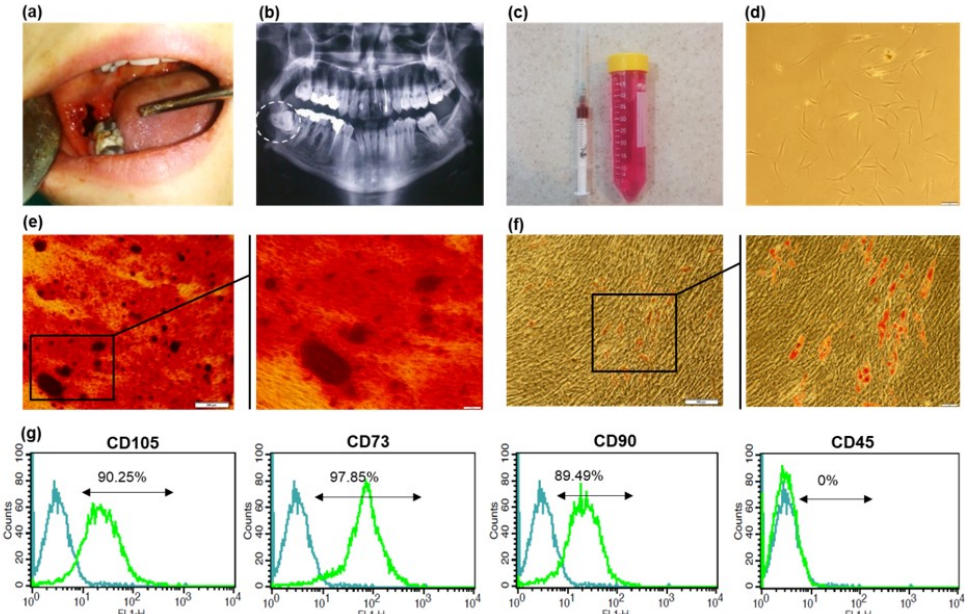
Figure 1. Isolation and characterization of a BMSCs. ( a ) Surgical extraction of impacted wisdom tooth ( b ) Panoramic radiography ( c ) Aspirated bone marrow in a heparinized syringe and alveolar bone particles in cell culture solution ( d ) Primary culture (P0) of aBMSCs with typical fibroblastic morphology (scale bar 100 µm) ( e ) Alizarin Red staining and ( f ) Oil Red staining of aBMSCs, following three weeks of osteogenic and adipogenic differentiation induction (×4, ×20 magnification) ( g ) The flow cytometric plots for specific MSC surface markers (CD105, CD90 and CD73) and CD45 as a hematopoietic surface marker. Isotype-matched antibodies were used as the internal control for all markers.